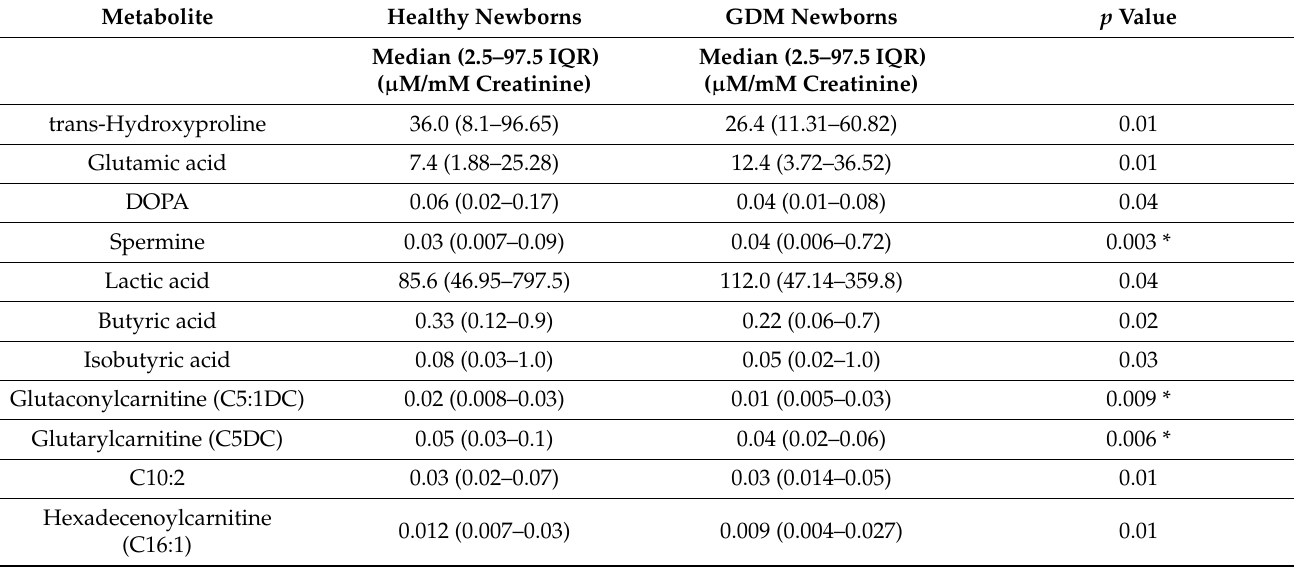
Table 2. Concentration values of statistically significant metabolites measured for babies born to mothers with GDM and healthy controls.